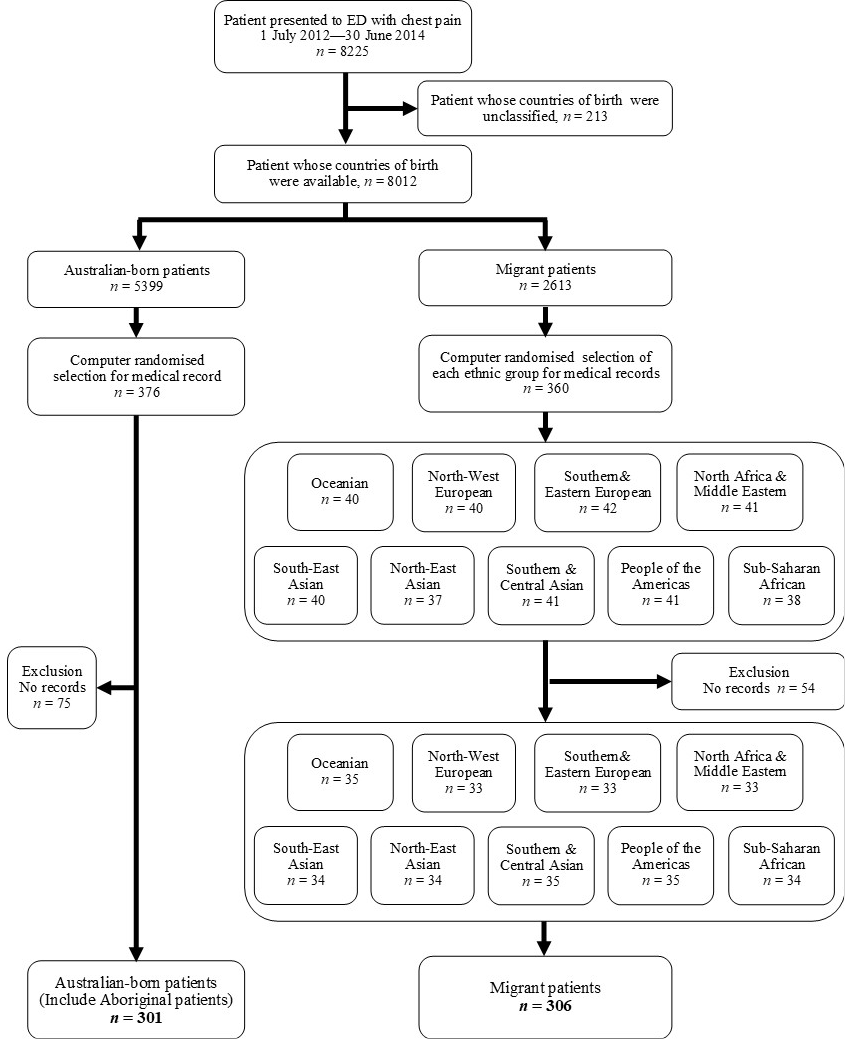
Figure 1. Study flow